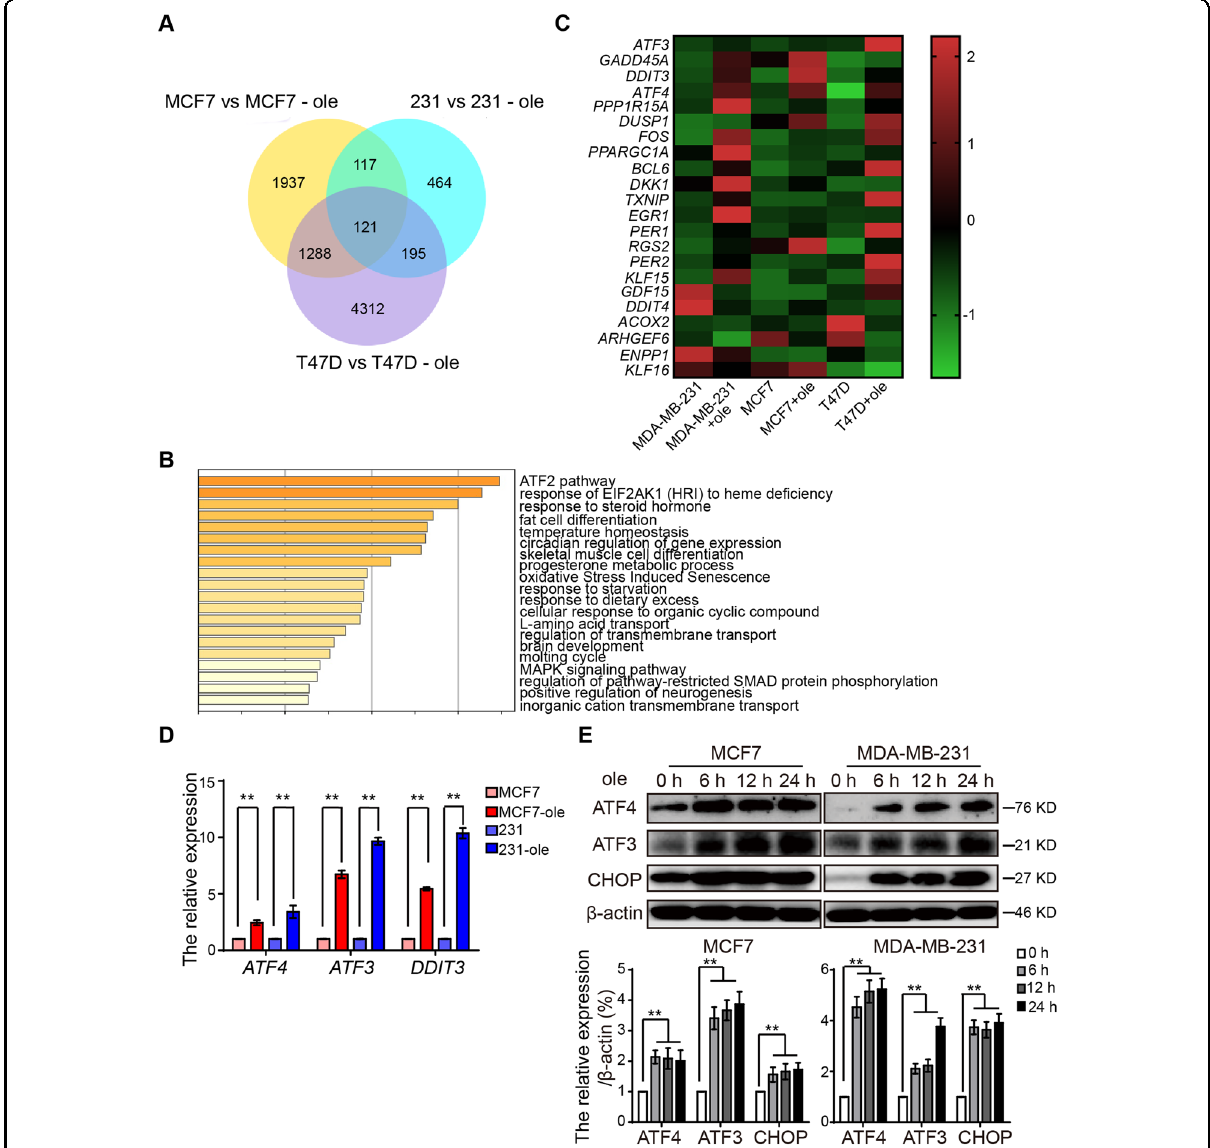
pathway analysis was performed functional enrichment of these different mRNA in GO and KEGG databases. C The heatmap was generated based on the signi fi cant different genes in ATF2 pathway. D , E The ATF3, ATF4, and CHOP ( DDIT3 ) expression was detected by qRT-PCR and western blotting. Data are presented as mean ± standard error of the mean from three independent experiments. ** p < 0.01. ole,